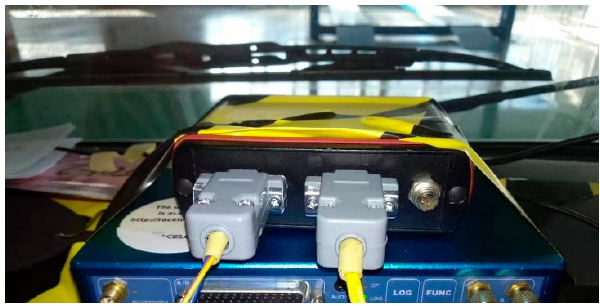
Figure 7. Physical diagram of the test hardware.